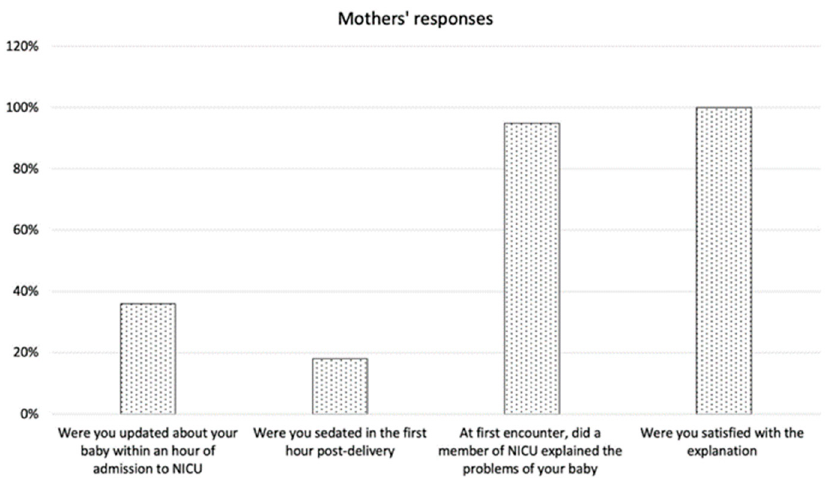
Figure 4. Summary of responses from mothers. Table 1. Summary of the Update Times.